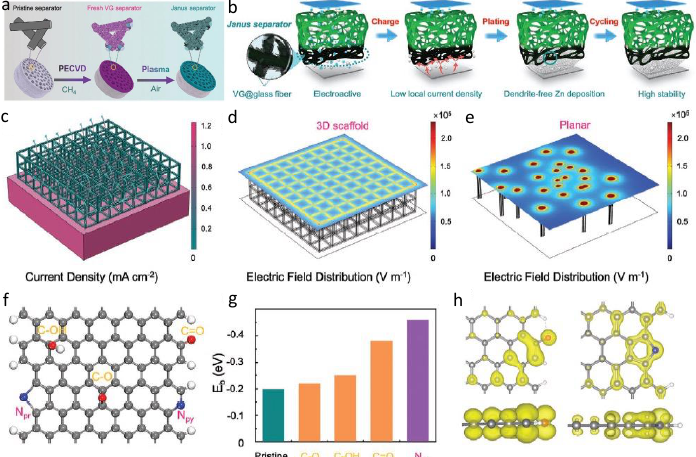
Figure 20. ( a ) Illustration of the synthetic process of the Janus separator, ( b ) demonstration of directly grown VG carpet on one side of the Janus separator which lowers local current density and homogenizes ion distribution, ( c ) current distribution in the 3D scaffold. The distribution of electric fields in ( d ) 2D planar structures (pristine separator case) and ( e ) 3D scaffold structures (Janus separator case), ( f ) N-doped and O-doped graphene configurations. Carbon, oxygen, nitrogen, and hydrogen atoms are indicated by gray, red, blue, and white colors, ( g ) the binding energy of Zn atoms on the O/N-functionalized graphene, and ( h ) the yellow contour with the isosurface value of 0.002 e bohr −3 of partial charge density around the fermi level by top view (upper) and side view (lower) in the C=O – G and C – N pr – G configuration from left to right. (Reproduced with permission. [38] Copyright 2020, John Wiley & Son).